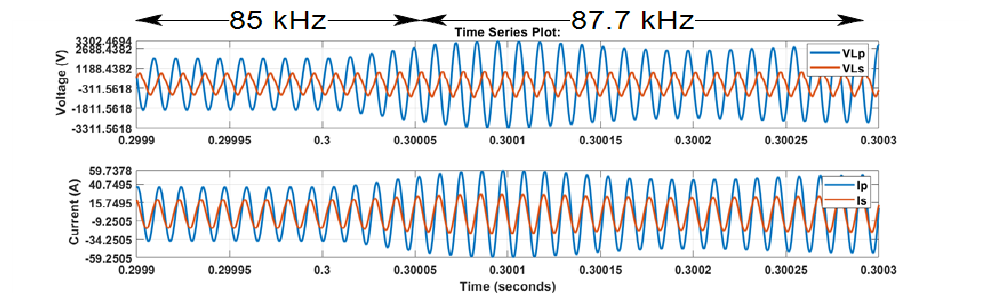
Figure 12. Voltage and current waveform of inductive track at M = 25 µ H while tuning.